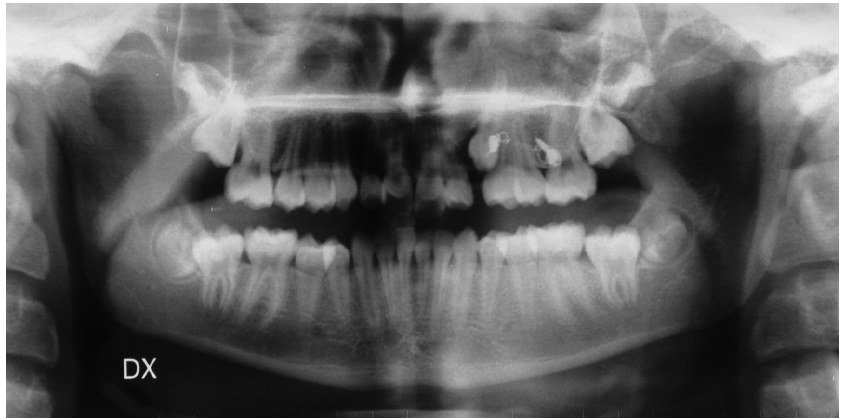
Figure A3. Post-treatment panorex of patient B.R. The distalization of 2.3 was obtained in 6 months.